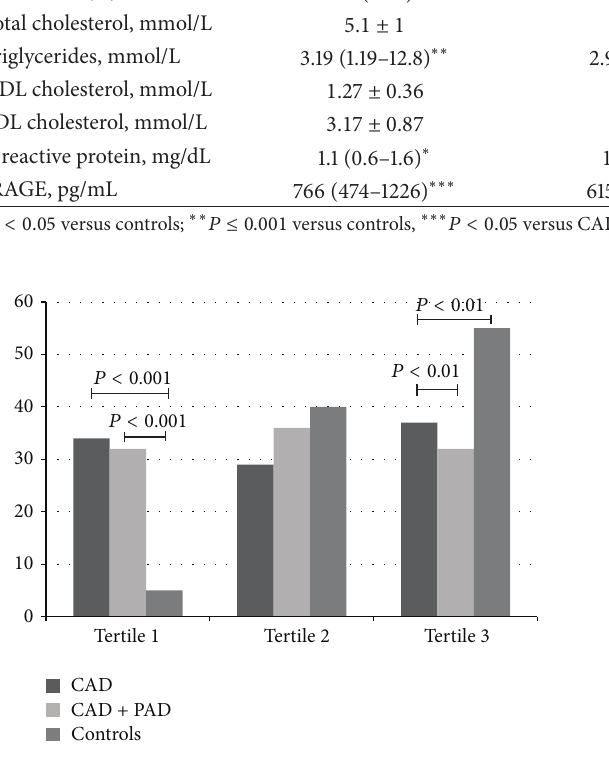
Figure 1: Percentage of subjects with CAD and CAD + PAD and controls according to tertiles of plasma sRAGE